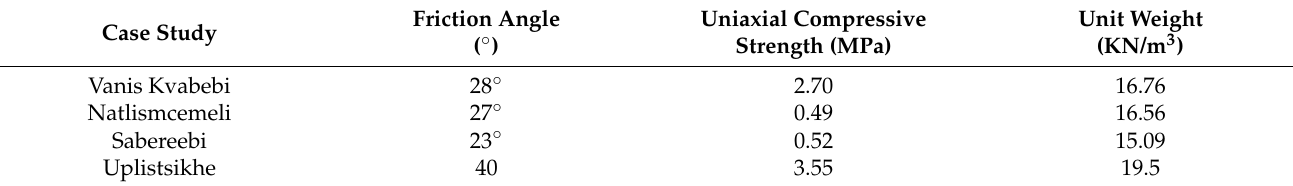
Table 3. Average values of the obtained geotechnical parameters of the collected samples. Case